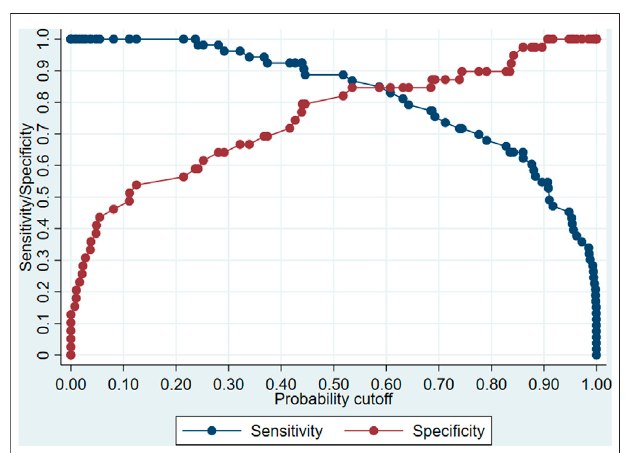
FIGURE 3 | Change in sensitivity and speci fi city of the model proposed topredictinfectionsinpatientsundergoingcytotoxicchemotherapyaccording to the cutoff point for the de fi nition of